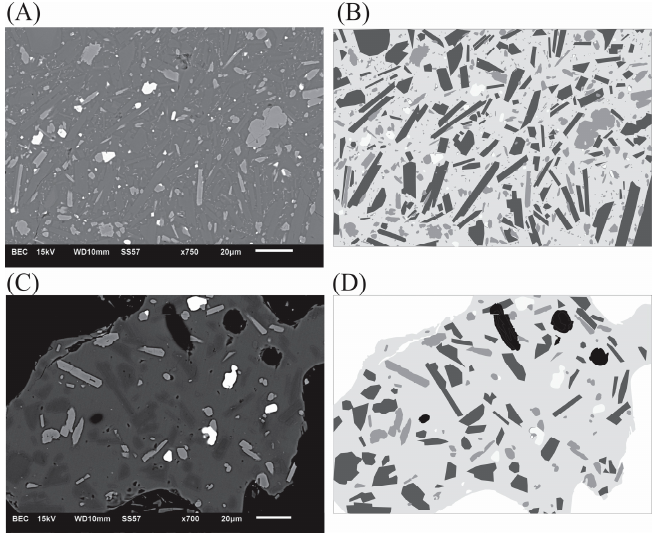
Figure 3. The result of componentry analysis of the volcanic ash from Showa crater during the January 2011–November 2012 eruptions.